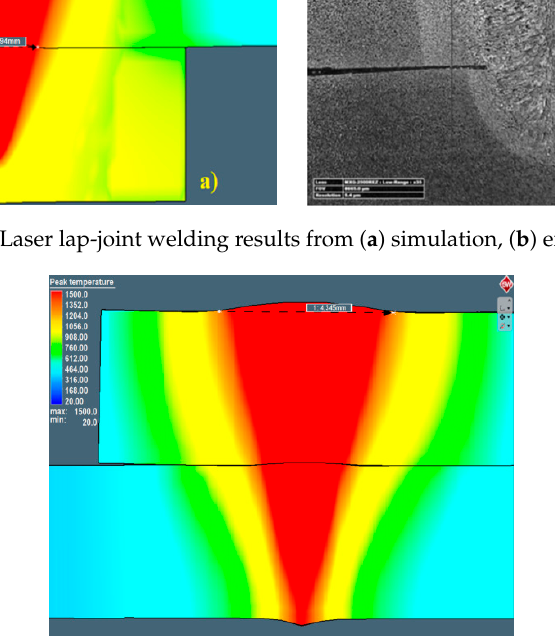
Figure 8. Laser lap-joint welding results for complete penetration.